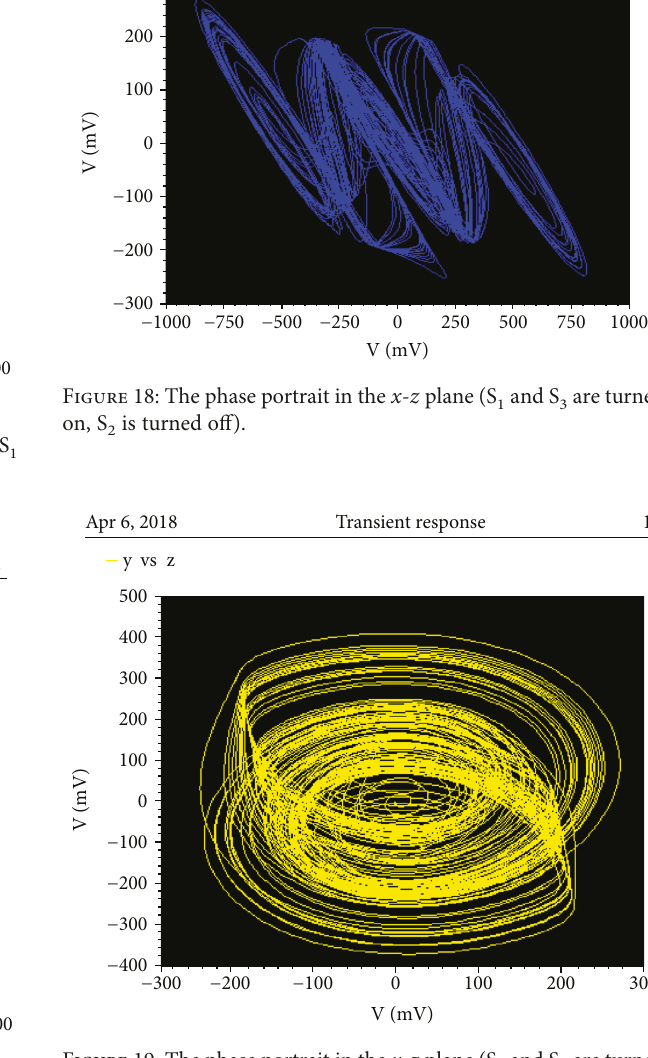
and S are turned 1 3